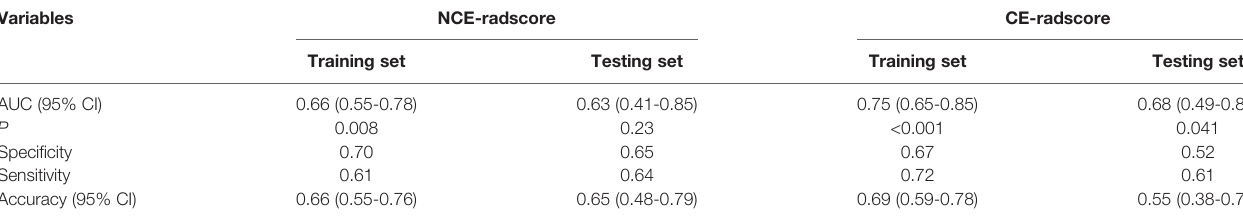
TABLE 4 | ROC analysis for the NCE-radiomics and CE-radiomics models from target lesions